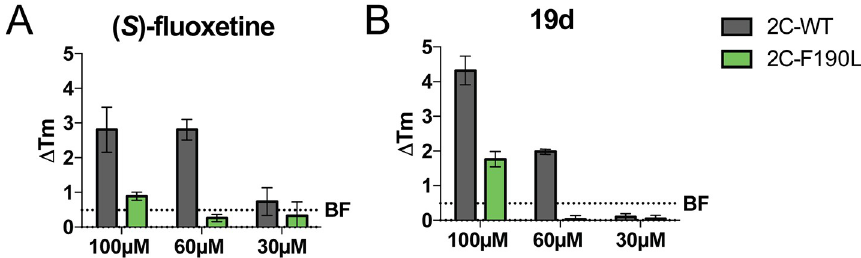
Fig 6. Resistance mutations in the α 2 helix of CV-B3 2C disrupt compound binding. The binding of (A) ( S )- fluoxetine and (B) 19d to a recombinant fragment of the CV-B3 2C protein and the CV-B3 2C α 2 helix mutant F190L was assessed by thermal shift assays. The thermal shift of 2C is represented by change in melting temperature ( Δ T m ). The dashed line represents data from the negative control BF738735, an inhibitor of the pan-EV host factor phosphateidylinositol-4-III β , used at a concentration of 100 μ M. Data shown are representative of one out of two experiments which were performed in technical triplicates. Error bars depict SD calculated from technical triplicates of the representative experiment. All underlying experimental data that are displayed can be found in S2 Data. CV, coxsackievirus; EV, enterovirus; Tm, melting temperature; WT, wild type.